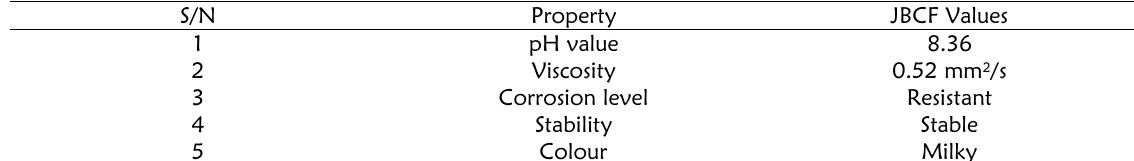
Table 9: Characteristics of oil-in-water emulsion cutting fluids